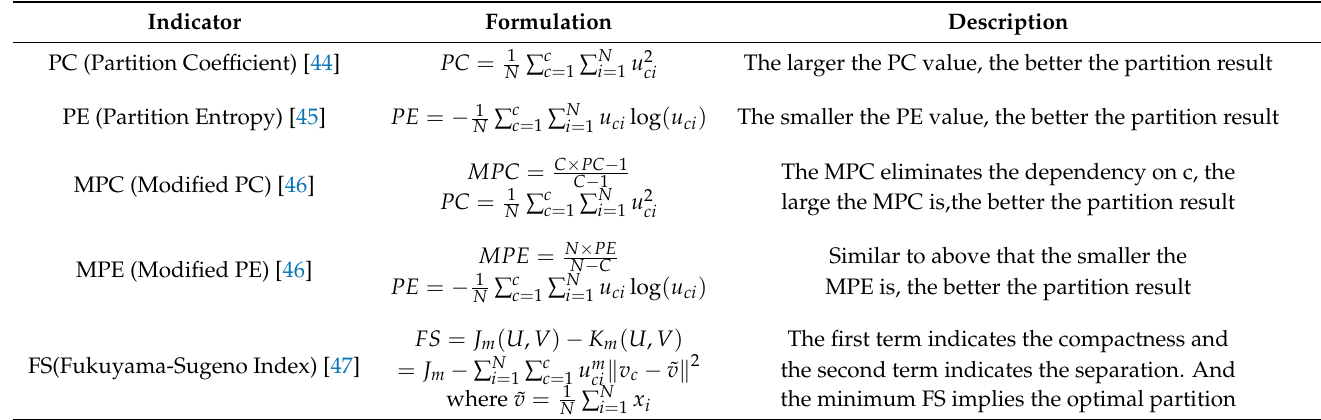
Table 1. The quantitative evaluation indicators used in simulation SAR image experiments for